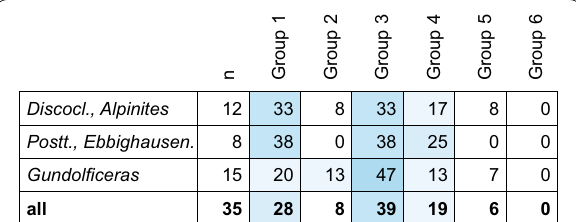
Fig. 12 Percentages of the six distinguished groups with different modes of septal distance in the morphologically successive Famennian tornoceratid